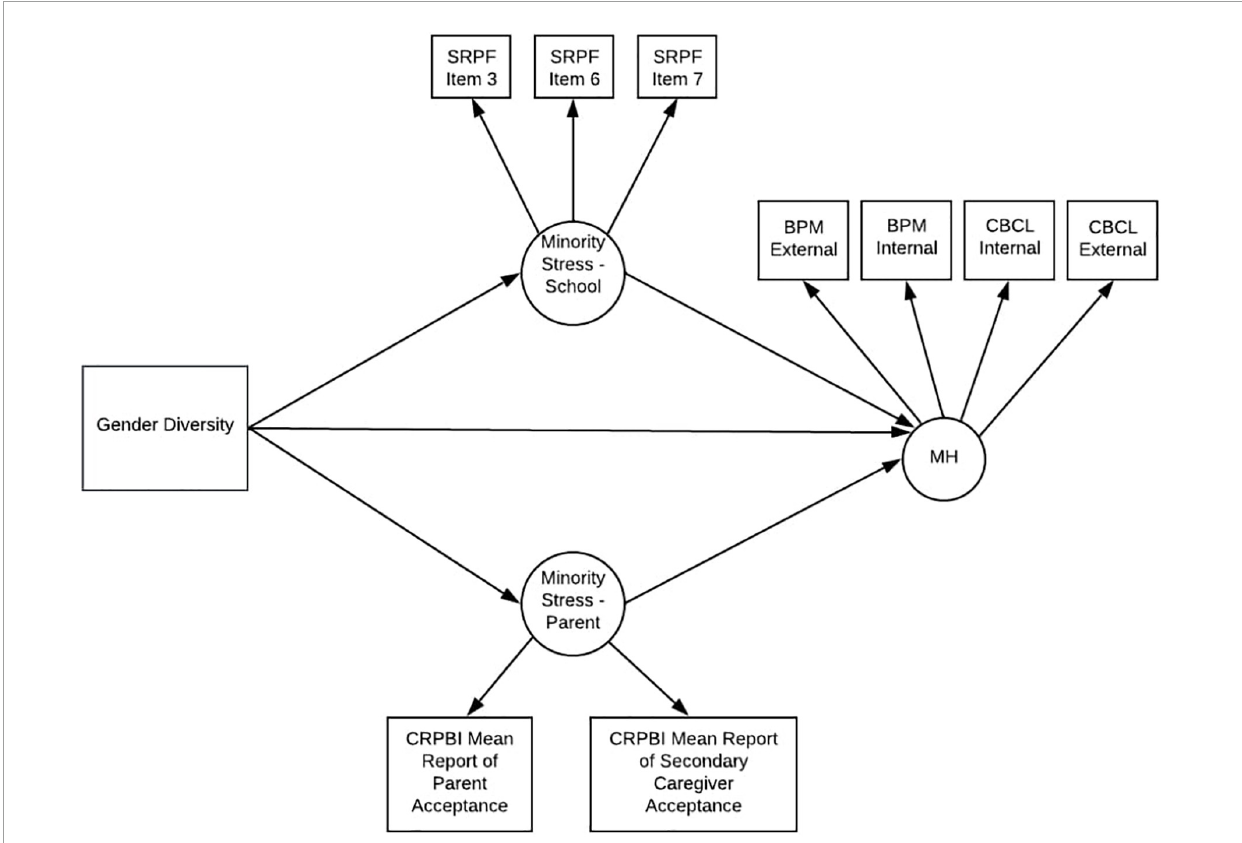
FIGURE3 Proposed behavioral model. SRPF, school risk and protective factors; Item 3 = “I get along with my teachers”; Item 6 = “I feel safe at my school”; Item 7 = “The school lets my parents know when I’ve done something well”; BPM, brief problem monitor (ASEBA brief problem monitor—youth form for ages 11–18); CBCL, child behavior checklist [child behavior checklist for ages 6–18 (CBCL/6–18)]; CRPBI, children’s report of parent behavior